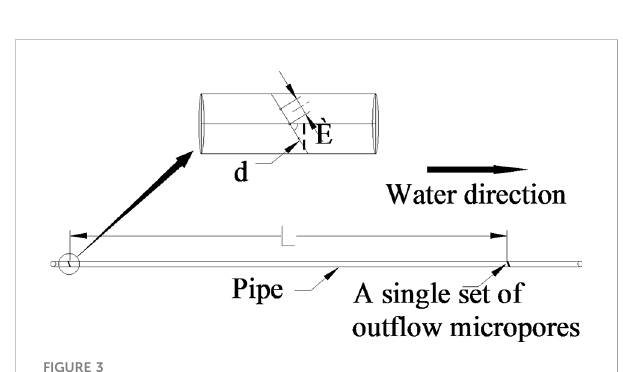
FIGURE 3 Micropores group (inside) spacing structure parameters (Zhang et al., 2020b). Diameter of micropore is d=0.8mm; The internal spacing of the micropores group was I =0.4cm; The Angle of micropores is =68º; The micropore group spacing is L.